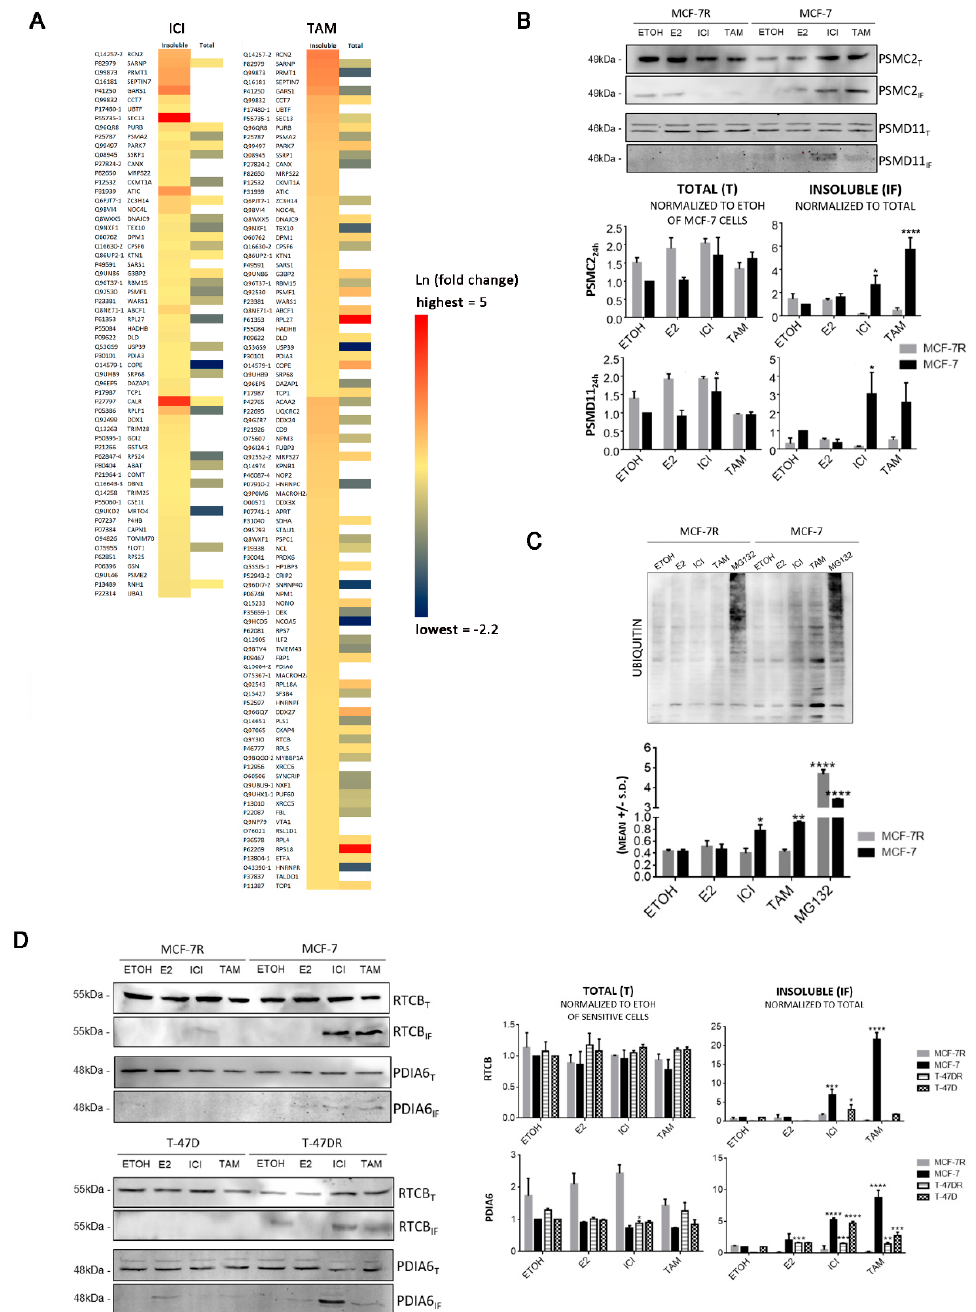
Figure 3. Protein aggregation induced by antiestrogens in MCF-7 cells. Cells were treated with 10 nM E2, 250 nM ICI or 500 nM TAM or the same volume of ETOH (control) for 24 h. Total (T) and detergent-insoluble (IF) protein fractions were analyzed by LC-MS/MS or Western blot. ( A ) Heat map showing fold-change differences (cutoff 30%) identified by LC-MS/MS. White spaces are proteins that were present in the insoluble fraction but not detected in the total protein fraction. ( B ) Western blot of total and insoluble PSMD11 and PSMC2. ( C ) Western blot showing total ubiquitin levels; 5 µM MG132 was used as positive control. ( D ) Western blot of RTCB and PDIA6 and band intensity quantification. In all cases, results are representative of two experiments. **** p < 0.0001, *** p < 0.001, ** p < 0.01 and * p < 0.05 vs. ETOH in the same cell line, non-parametric t test.